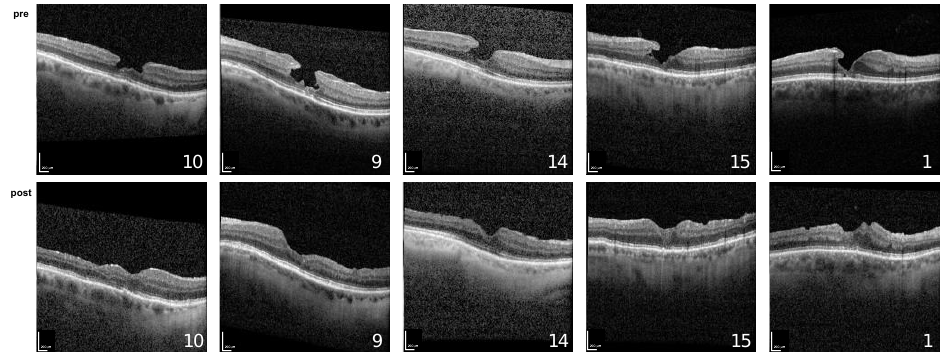
Figure 1. Spectral domain optical coherence tomography of patients (ID 1, 3, 7, 9, and 10) conducted preoperatively ( top ) and at the most recent follow-up ( bottom ); scale bar = 200 µm. Figure 1: Preoperative (up) and after longest follow-up/postoperative (below) spectral-domain optical coherence tomography of patients pre